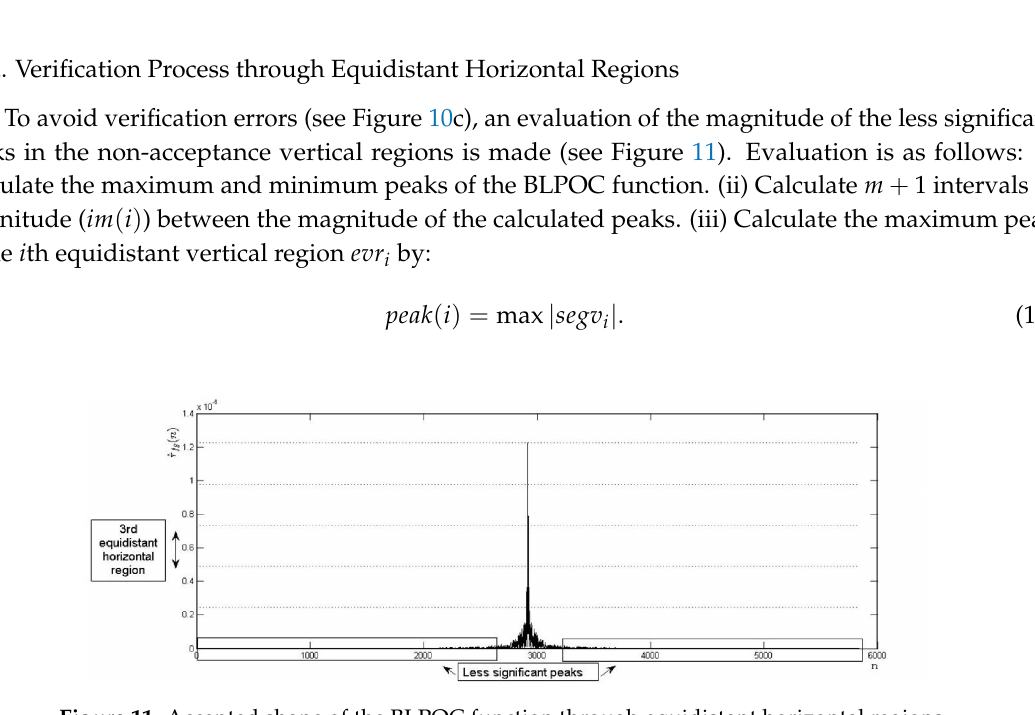
Figure 11. Accepted shape of the BLPOC function through equidistant horizontal regions. (iv) Compare the identified peaks ( peak ( i ) ) with the maximum acceptance horizontal region. The number of intervals of magnitude in the experiments was a constant value n = 5. On the other hand, the maximum acceptance region was the third equidistant horizontal region, as shown in Figure 12.